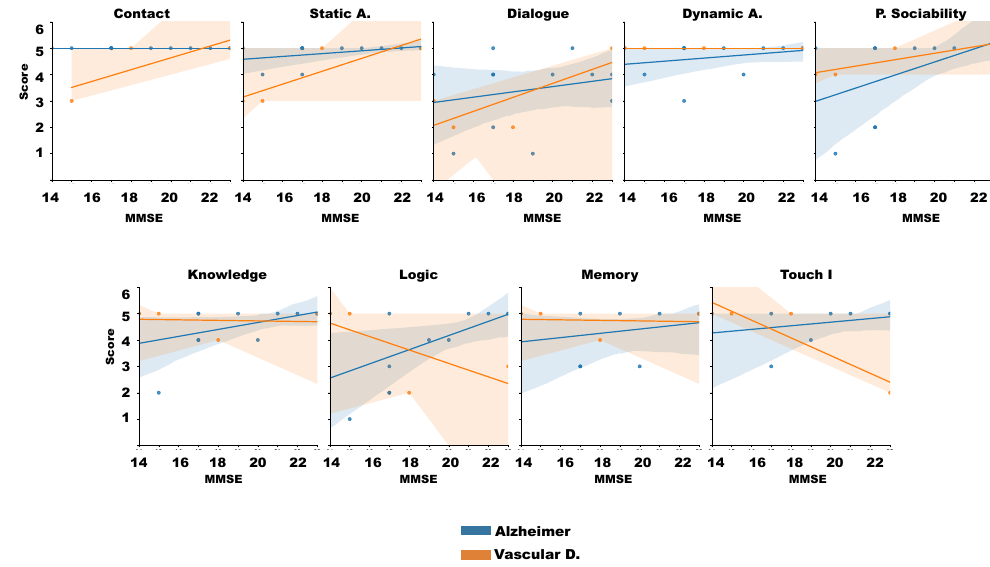
Figure 11. Correlation of Likert test and patient